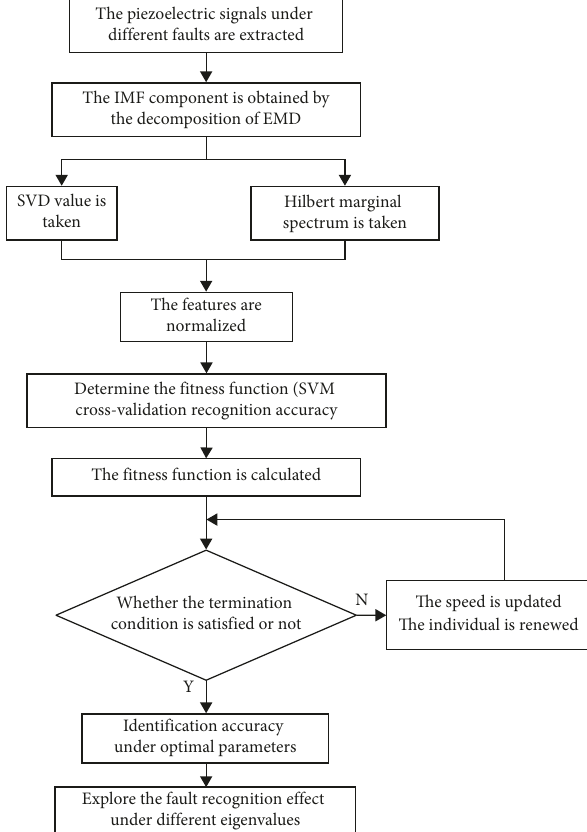
Figure 1: Experimental flow chart.